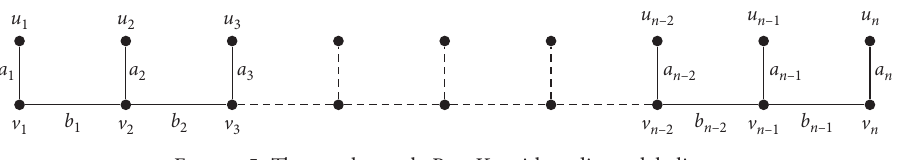
K with ordinary labeling. n ⊙ 1